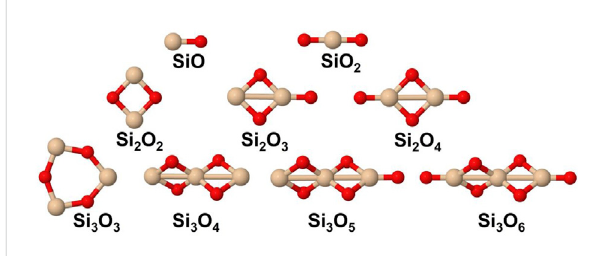
Silicon oxide species included in the present study. Silicon atoms are shown in beige and oxygen atoms in red.